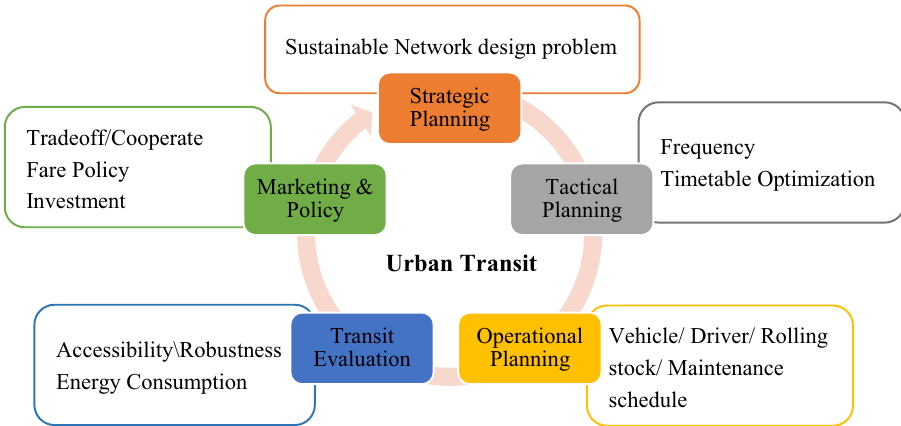
Fig. 2 Five parts of the